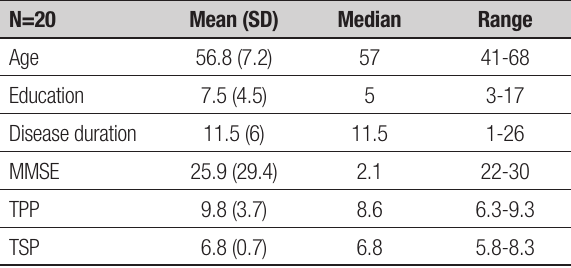
Table 1. Data on demographic and clinical